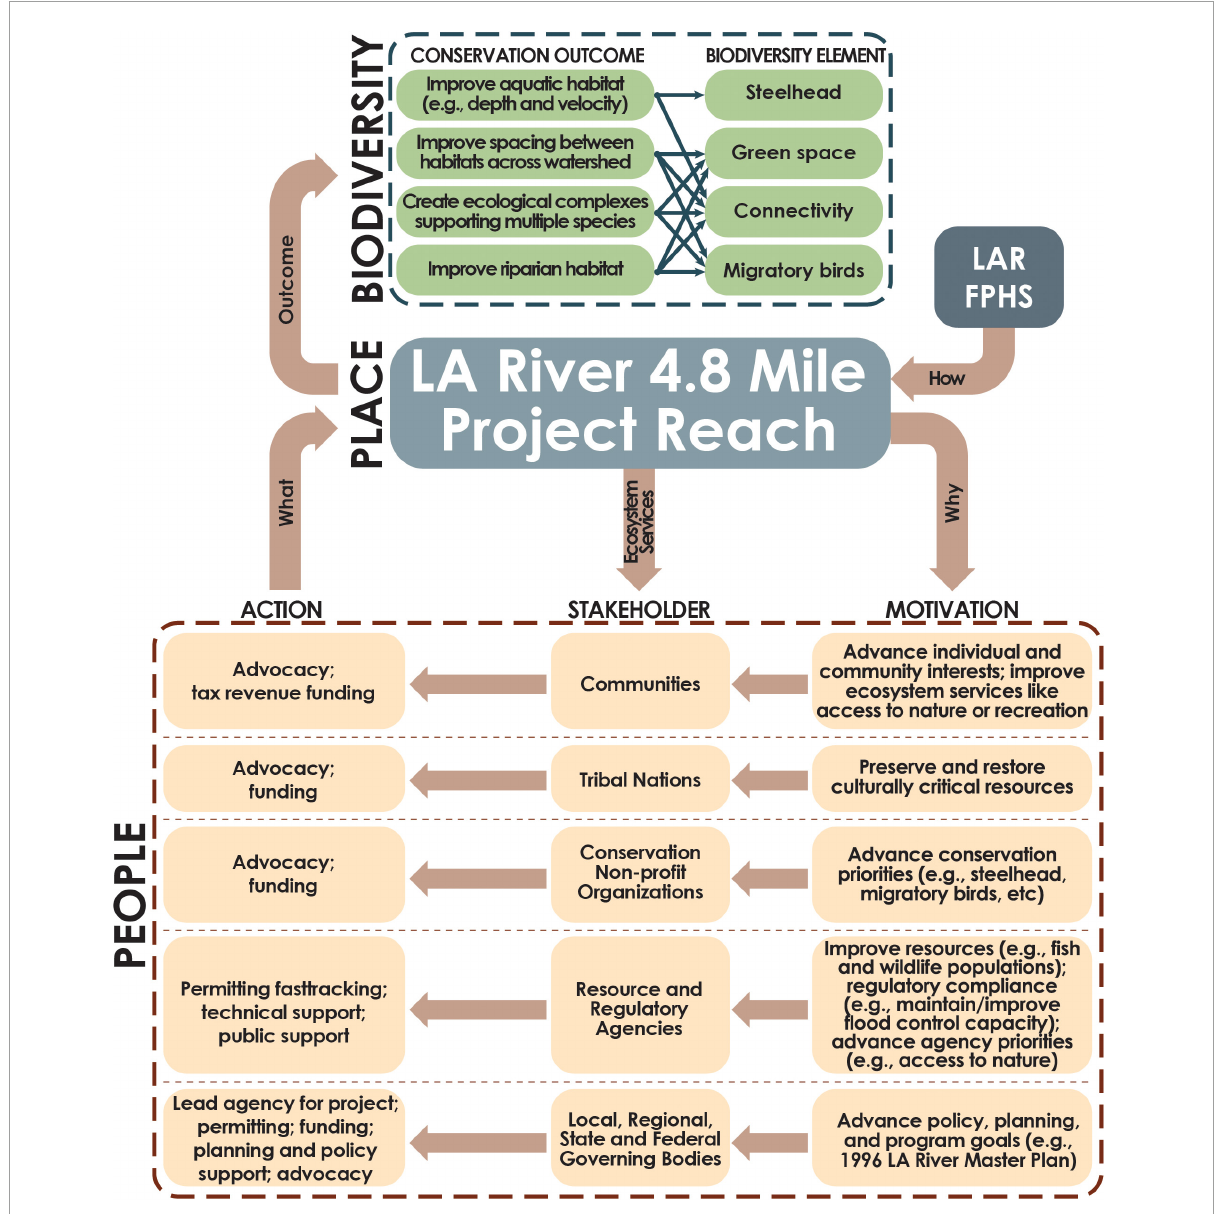
FIGURE1 The LA River Fish Passage and Habitat Structures (LAR FPHS) project advances a virtuous socioecological cycle in the 4.8-mile project reach of the LA River between the Glendale Narrows and Washington Boulevard. The LAR FPHS is designed to provide motivations for a wide range of stakeholders to take actions to support conservation in the LA River that advances multiple social and ecological priorities and ecosystem services of stakeholders and promotes urban biodiversity. In this diagram, the arrows flow initially from the LAR FPHS project to the “Place” box because it is “how” the virtuous cycle is started. Next, the arrows flow from the “Place” box to the “Motivations” column in the “People” box to highlight how the LAR FPHS project is designed to provide specific motivations for “why” individual stakeholders would want to engage in the virtuous cycle, so stakeholder support is not necessarily dependent on the stakeholders valuing the planned conservation outcomes or biodiversity enhancements of the project. Arrows continue to flow from “Stakeholders” column of the “People” box to the “Action” column to emphasize “what” actions engaged stakeholders can take to support the LAR FPHS in this reach of the LA River. Ecosystem services flowing from the “Place” box to the “Stakeholder” column of the “People” box shows how ecosystem services inherently are provided to stakeholders by the river reach, and enhancements in ecosystem services from the conservation project will provide direct positive benefits to stakeholders that contribute to perpetuating the virtuous cycle. Additionally, there are conservation outcomes flowing from the “Place” box to the “Biodiversity” box that show the conservation outcomes the LAR FPHS is designed to achieve (left column of the top “Biodiversity” box) and how these outcomes enhance various biodiversity elements (right column of the top “Biodiversity” box) within the project reach. Please note that the virtuous cycle shown is a simplified summary that only highlights some of the key components (e.g., stakeholders, conservation outcomes) in this conservation project and the reach of the LA River. An organically self-perpetuating virtuous cycle would expand to engage more stakeholders and produce more conservation outcomes across the LA River